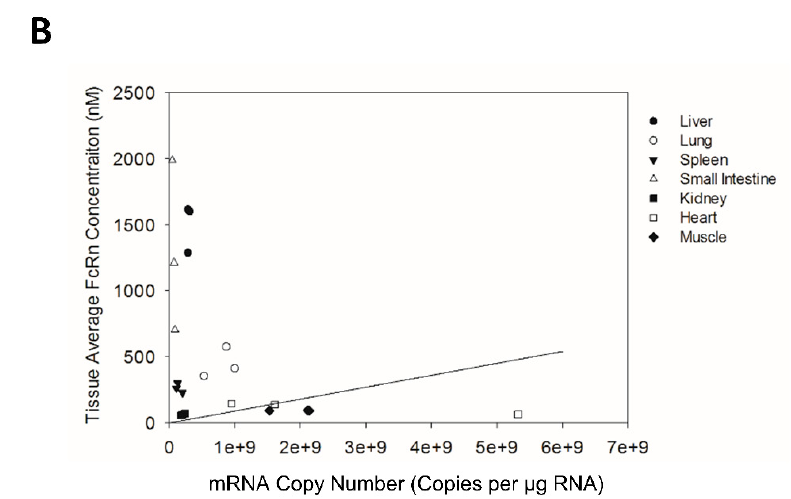
Figure 5. Correlation between mFcRn mRNA and protein expression in Swiss Webster mice ( A ) and transgenic mice ( B ). Individual mouse tissue mRNA abundance plotted against tissue protein abundance. Regression analysis showed significant ( p < 0.0005) correlation between tissue FcRn mRNA and protein expression in Swiss Webster mice with R 2 value of 0.1131. Regression analysis showed no significant correlation between tissue FcRn mRNA and protein expression in transgenic mice.